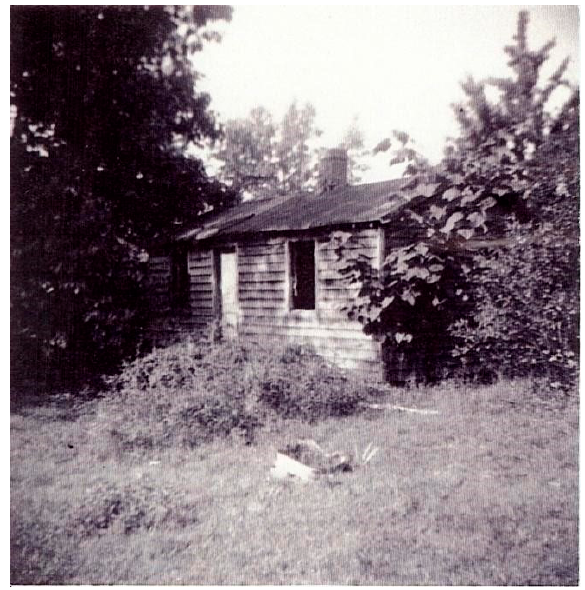
Figure 1. Our Homestead. (Photograph: circa 1950s—courtesy of Viola Wilson).